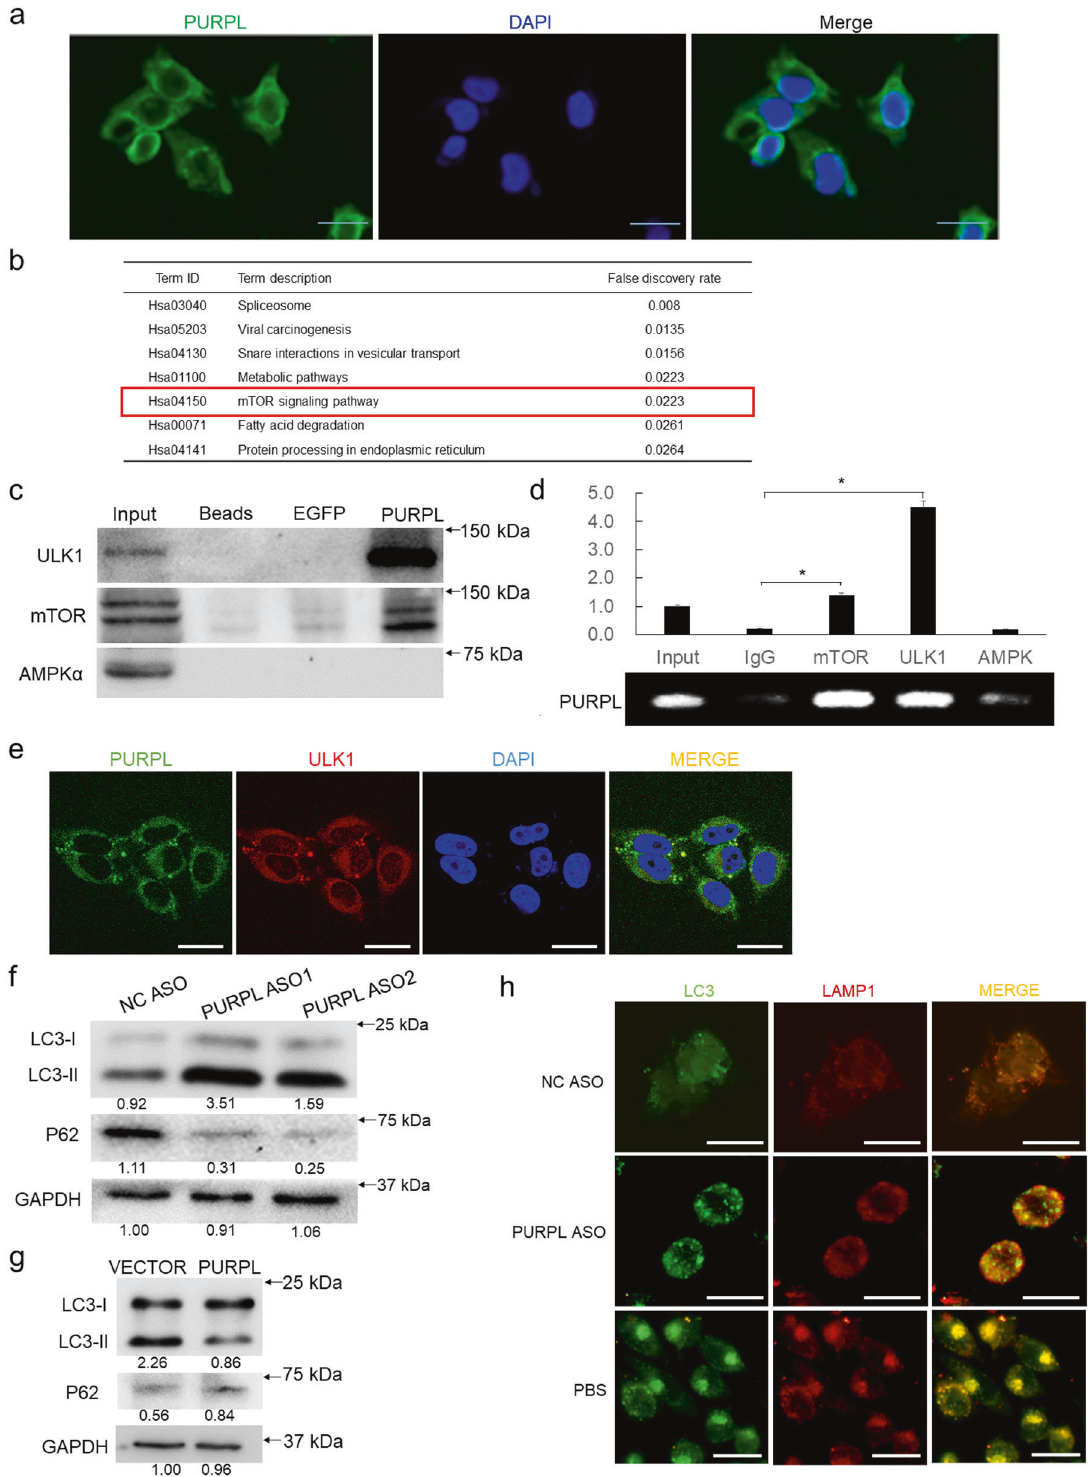
regulates one of the above two types of autophagy, we performed fl uorescence-activated cell sorting (FACS) analysis with Annexin V- FITC/PI double staining and found that a large portion of cells are clustered in the fi rst quadrant, which is quite different from the death induced by apoptotic inducer staurosporine in A375 cells (Fig. 5a) and in SK-MEL-28 cells (Supplementary Fig. S2e). Considering PURPL can regulate autophagy, we hypothesized that